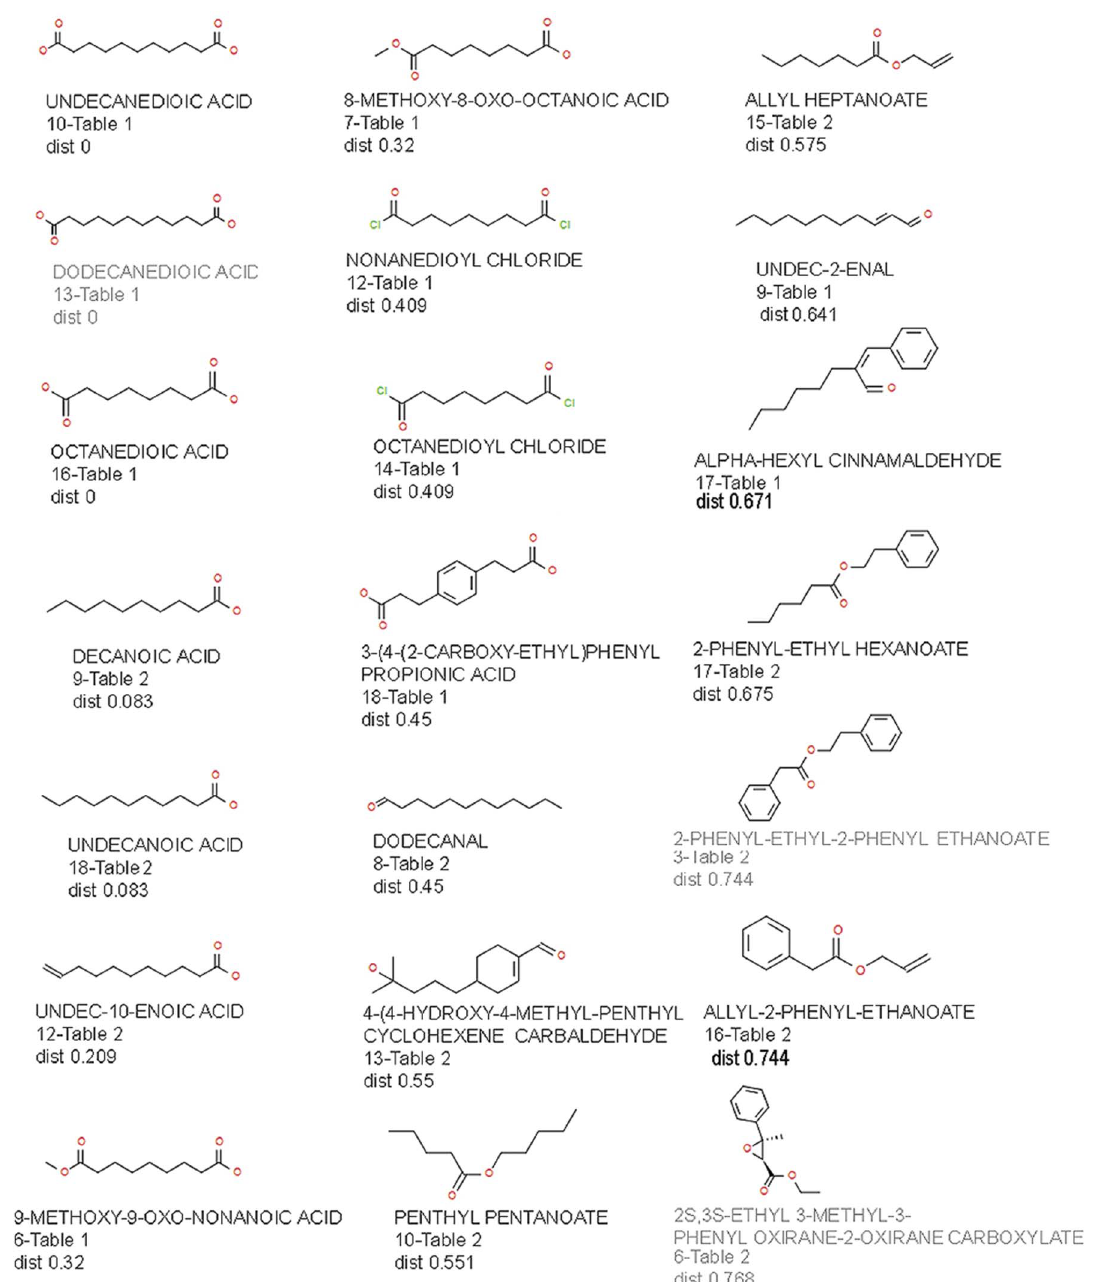
Figure 5. Ligands for MOR42-3 identified by VLS screening and their structural similarity to nonanedioic acid expressed as a fingerprint distance from nonanedioic acid. (Antagonists are labeled in